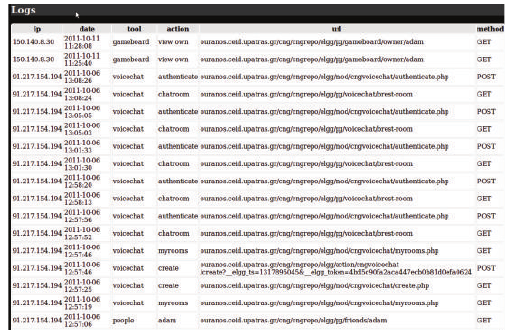
Figure 14: Raw logs for a specific user’s activity.